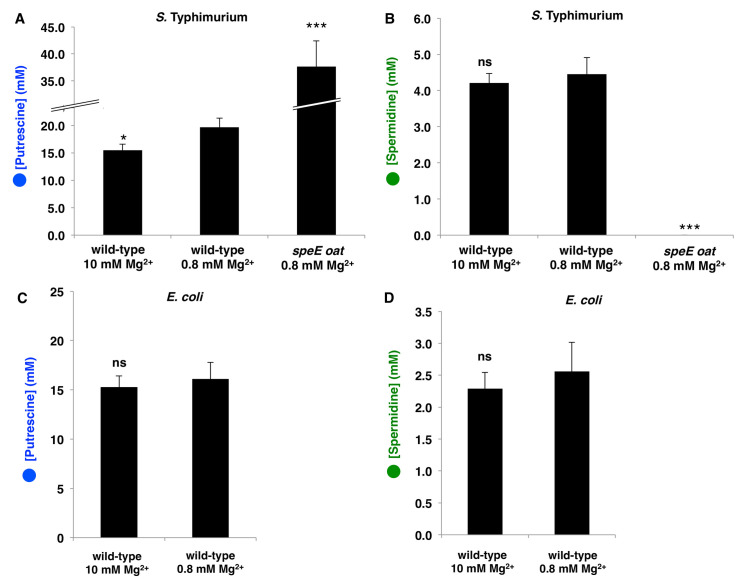
Intracellular concentrations of polyamines determined.A,B: Concentrations of putrescine (A), spermidine (B) and spermine were assessed by HPLC in exponentially growing wild-type S Typhimurium strain 14028s or the isogenic speE oat mutant (AAD58) in N-minimal medium with the indicated Mg2+ concentrations. Stars denote statistical significance compared to wild-type in 800 μM Mg2+. ***: p<0.001; *: p<0.05; ns: not significant (Student’s t-test, n = 3). C,D: Same as above but for wild-type E. coli strain MG1655. None of the tested polyamines was detectable in the speB speC speF mutant (AAD95). Spermine was not detected under the investigated conditions (detection limit = 0.2 mM).